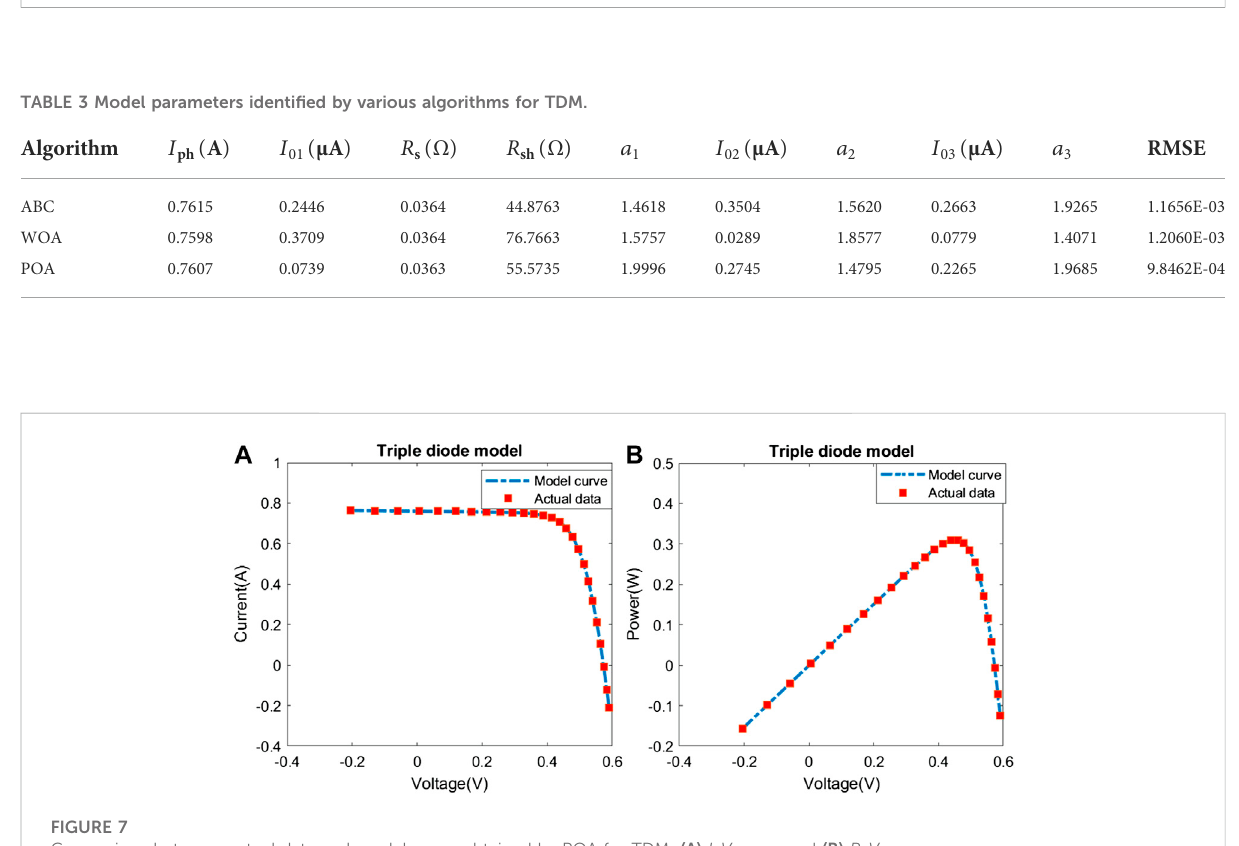
Figure 5 illustrate the I-V curve and P-V curve fi tting results obtained by POA under DDM, which indicates that the identi fi ed